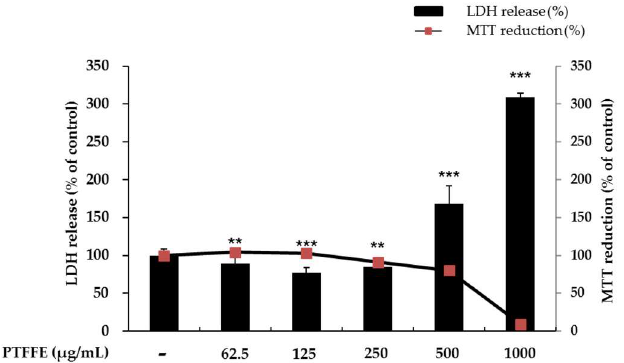
Figure 1. Effects of P. tinctorium fermented flower extract (PTFFE) on the viability of B16F10 melanoma cells. The cells were treated with PTFFE at the indicated concentrations for 48 h. Cell viability is expressed as a percentage relative to the value for the untreated cells. The data are presented as the mean ± standard deviation (SD) of at least three independent experiments. ** p < 0.01, *** p < 0.001.